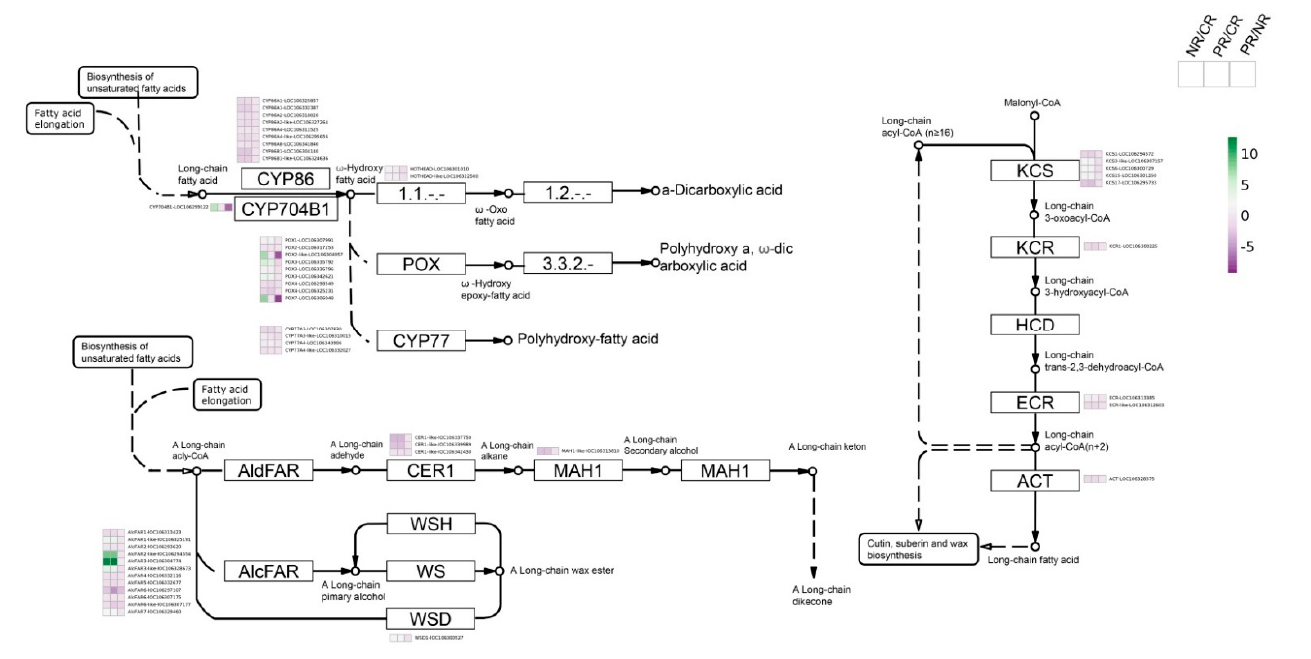
Figure 7. BoPEP4 treatment enhances wax and cutin accumulation under salt stress. Expression of the genes associated with cuticular wax biosynthesis. Detailed expression data are available in Table S7.